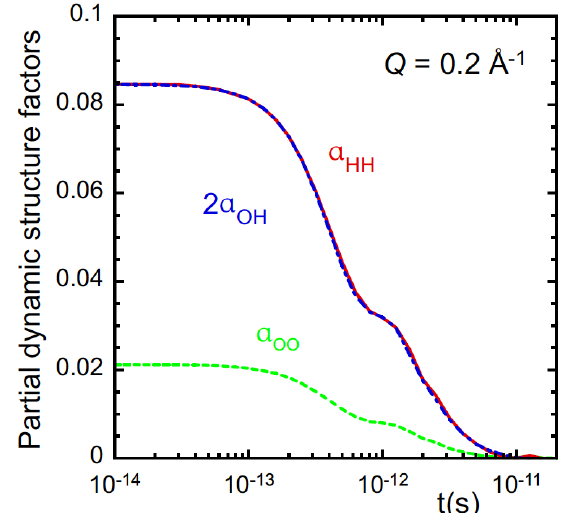
Fig. 4. Partial dynamic structure factors 𝑎 BC (𝑄,𝑡) ( 𝛼,𝛽 ∈ {H,O} ) calculated from the simulations for Q = 0.2 Å 34 : (0.2,𝑡) (continuous red line); 𝑎 (0.2,𝑡) (dashed green 𝑎 pp nn line); 2𝑎 np (0.2,𝑡) (dashed-dotted blue line). light water ( H O). The intensity of S ( Q , t ) for Q = 0 0.2 Å 34 and 𝑡 ≅ 10 34(cid:146) s results to be in the case of D O 0 about 125 times larger than that corresponding to H 0